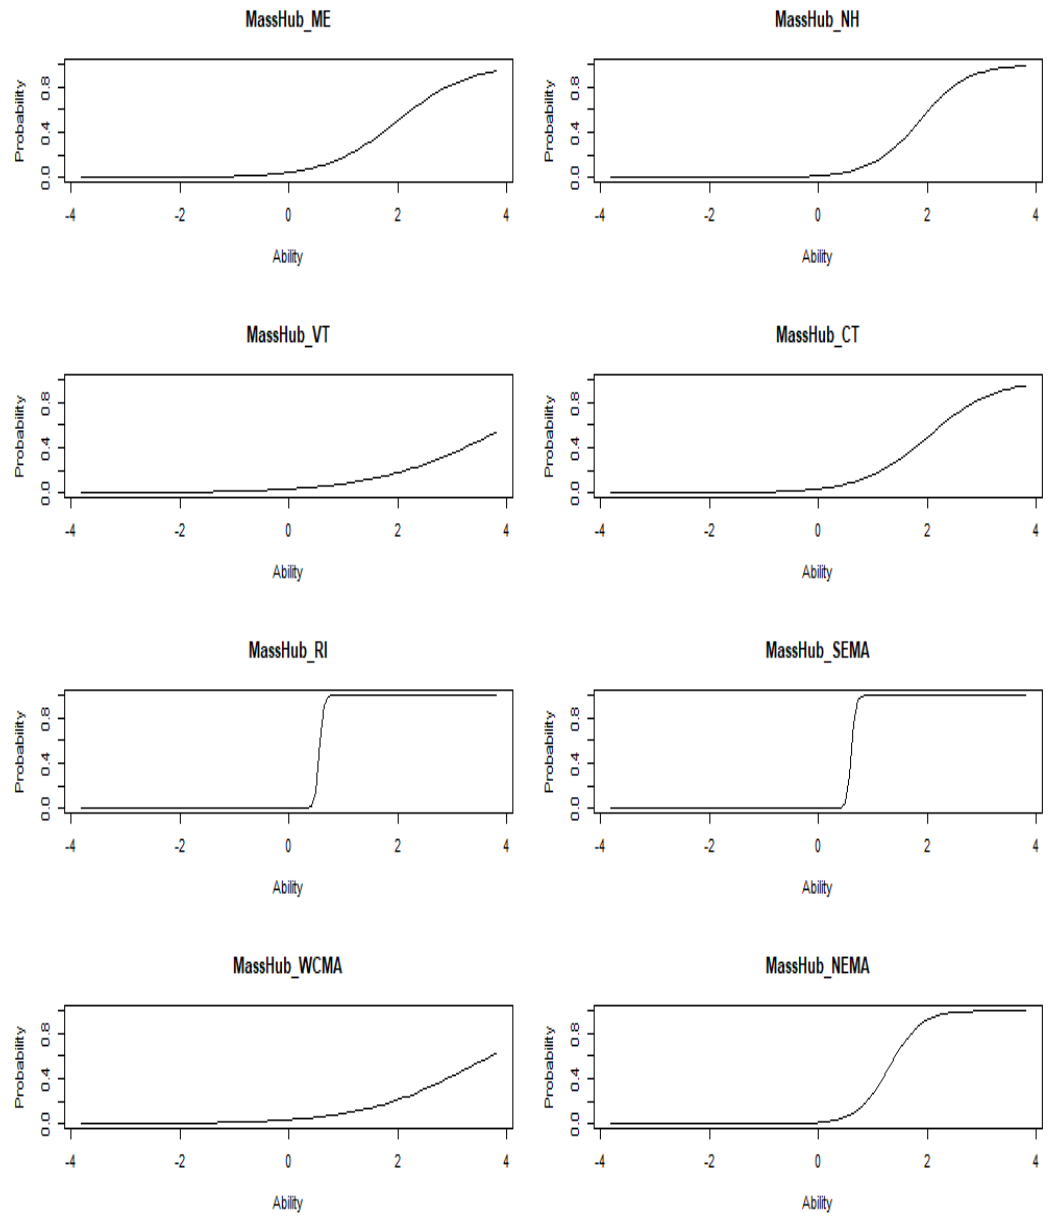
Figure 5. Individual item characteristic curves: eight paths.